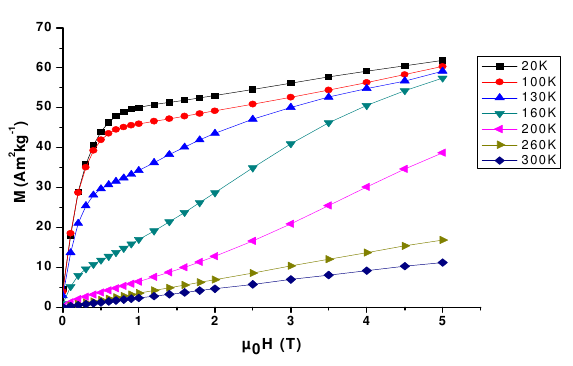
Fig. 5 : M (H) curves at several temperatures for La